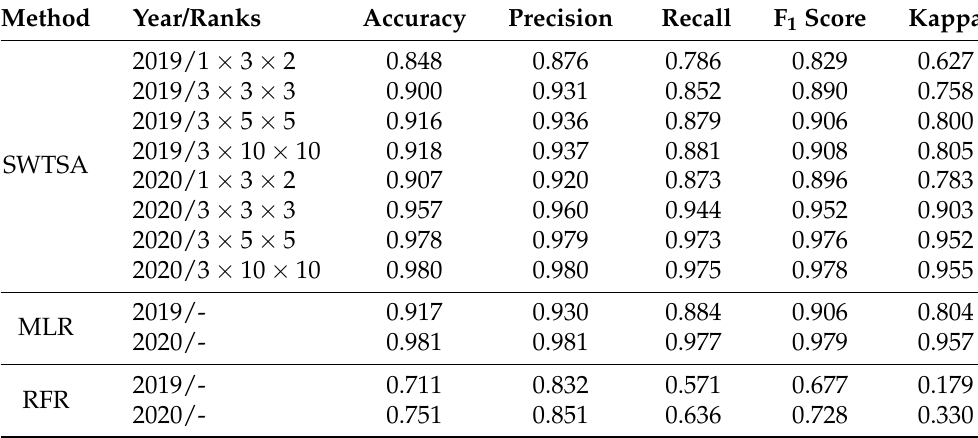
Figure 4. Cumulative frequency distributions of NDVI for actual and reconstructed values. Table 2. Performance evaluation of